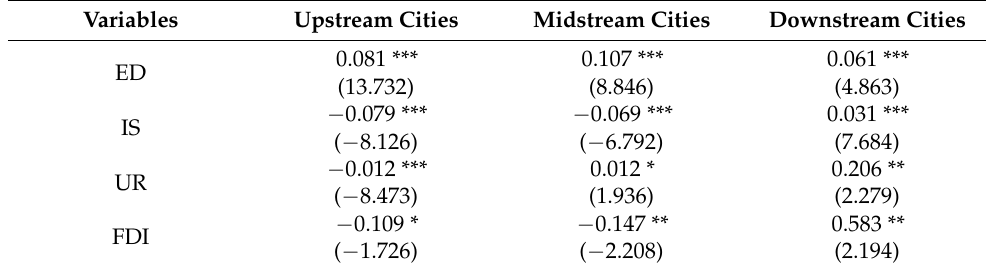
Table 8. Robustness test